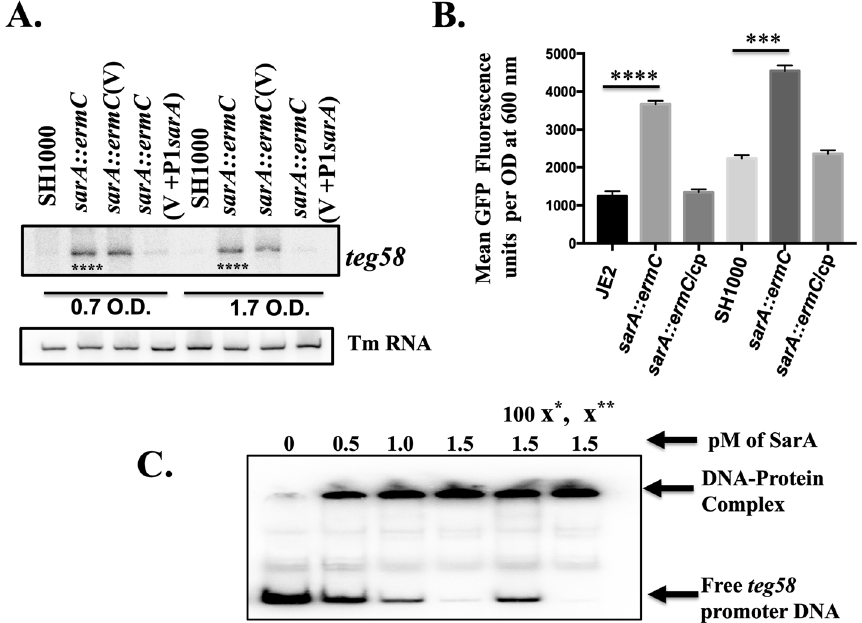
Figure 2. SarA repressed teg58 . ( A ) Northern blot analysis of various strains as indicated. 15 μg of total cellular RNA was loaded to each lane. Tm RNA (NCTC8325 SRD:S329) is the loading control. V, indicating shuttle plasmid pSK236 control and V + P1 sarA , indicating 590 bp containing P1 promoter region along with the sarA gene. The relative band intensity of various lanes was scanned by Image J software (NIH) and statistical significance was calculated by setting the wild type band intensity as 100. Original blots are presented in Supplementary Material files Fig. X1A,B. ( B ) teg58 promoter analysis with fusion to GFP reporter system. A 210 bp teg58 promoter fragment was cloned upstream of the promoterless gfp uvr gene. Cp standing for chromosomal complementation of the sarA mutant. Means and standard deviations from triplicate experiments are shown. Student t -test (* P < 0.05, ** P < 0.01; *** or ****P < 0.0001). ( C ) PhosphorImager image of 8.0% polyacrylamide gel showing binding of purified SarA protein to 210-bp promoter fragment of teg58 . ASupplpproximately 0.02 pM of radiolabeled DNA fragment was used in all lanes. For competition assays, 100-fold molar excesses of the unlabeled promoter DNA (x*) and nonspecific competitor DNA (X**, a 200-bp internal fragment of the 16S rRNA gene) were added separately as shown. The arrows indicate the free labeled DNA or the DNA–protein complex. Original blot is presented in ementary Material files Fig.